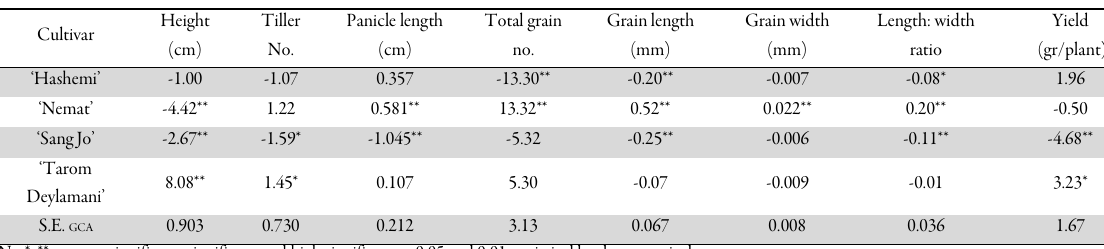
Table 4. Estimation of GCA effects for studied traits Cultivar